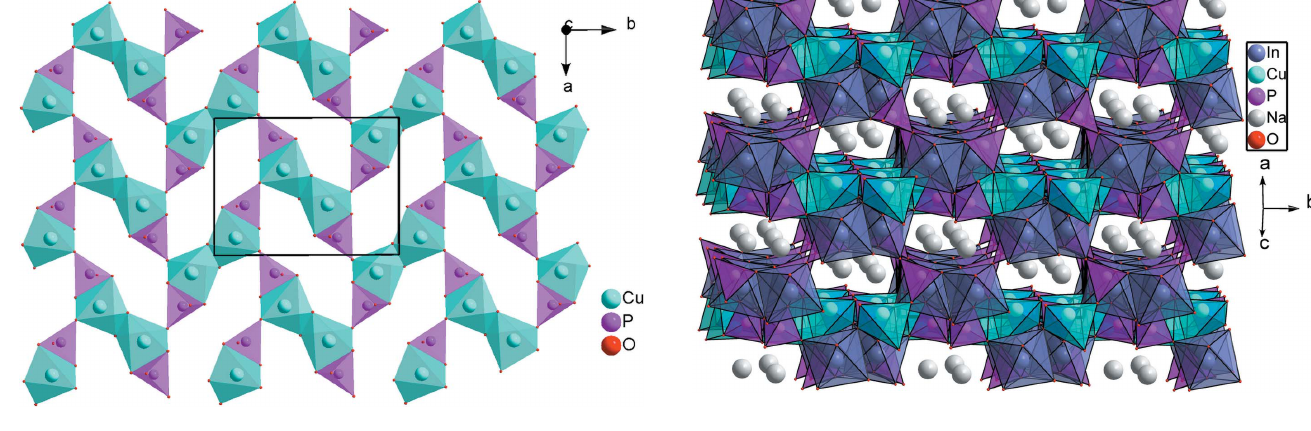
Figure 4 The sodium cations located in channels running parallel to [101] in the crystal structure of NaCuIn(PO 4 ) 2 .